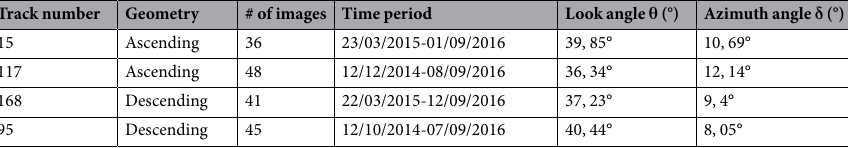
Table 1. Details of the datasets of Sentinel-1A data used to set up the baseline (first processing). The multi-interferogram SqueeSAR approach was used to provide ground deformation data and to identify the measurement points in the Tuscany Region. Sentinel-1 data are freely accessible through the Sentinels Scientific Data Hub